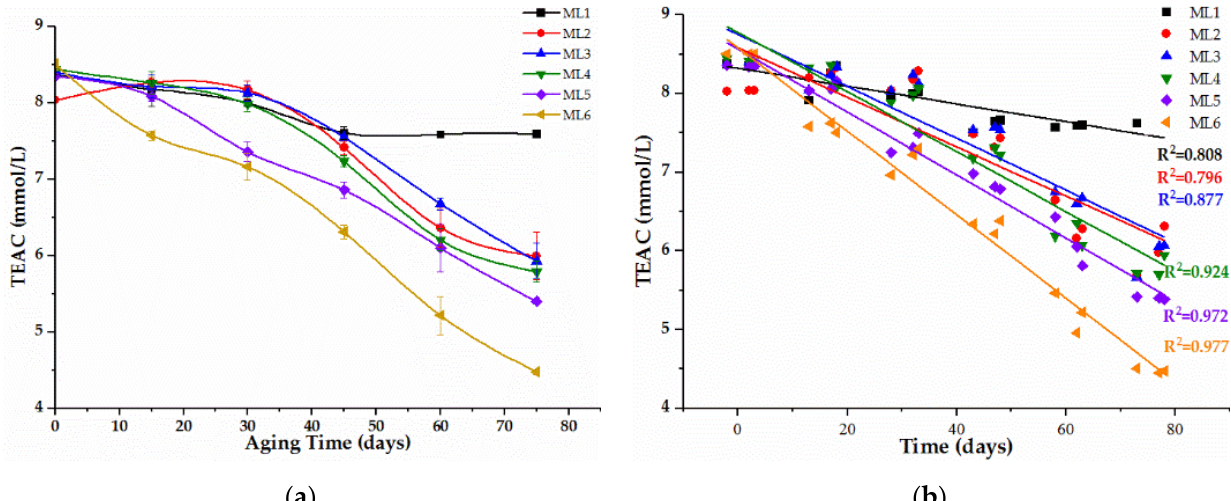
Figure 1. Evolution of antioxidant activities ( a ) and its correlation with aging time ( b ) during wine aging of 75 days. Note: ( a ), each spot represents a set of the arithmetic average ± standard deviation of one measurement, each performed on triplicate bottles; ( b ), each spot represents a set of data of each measurement performed on each bottle and font color for “R 2 ” is consistent with color for each correspondent spot. Abbreviations: TEAC, antioxidant activities were expressed as Trolox equivalents per liter of wine (mM TEAC/L); ML1, wines containing 7.86 ± 0.10 mg/L acetaldehyde; ML2, wines containing 41.72 ± 1.97 mg/L acetaldehyde; ML3, wines containing 61.19 ± 3.93 mg/L acetaldehyde; ML4, wines containing 128.10 ± 3.08 mg/L acetaldehyde; ML5, wines containing 203.02 ± 6.00 mg/L acetaldehyde; ML6, wines containing 259.02 ± 4.95 mg/L acetaldehyde.